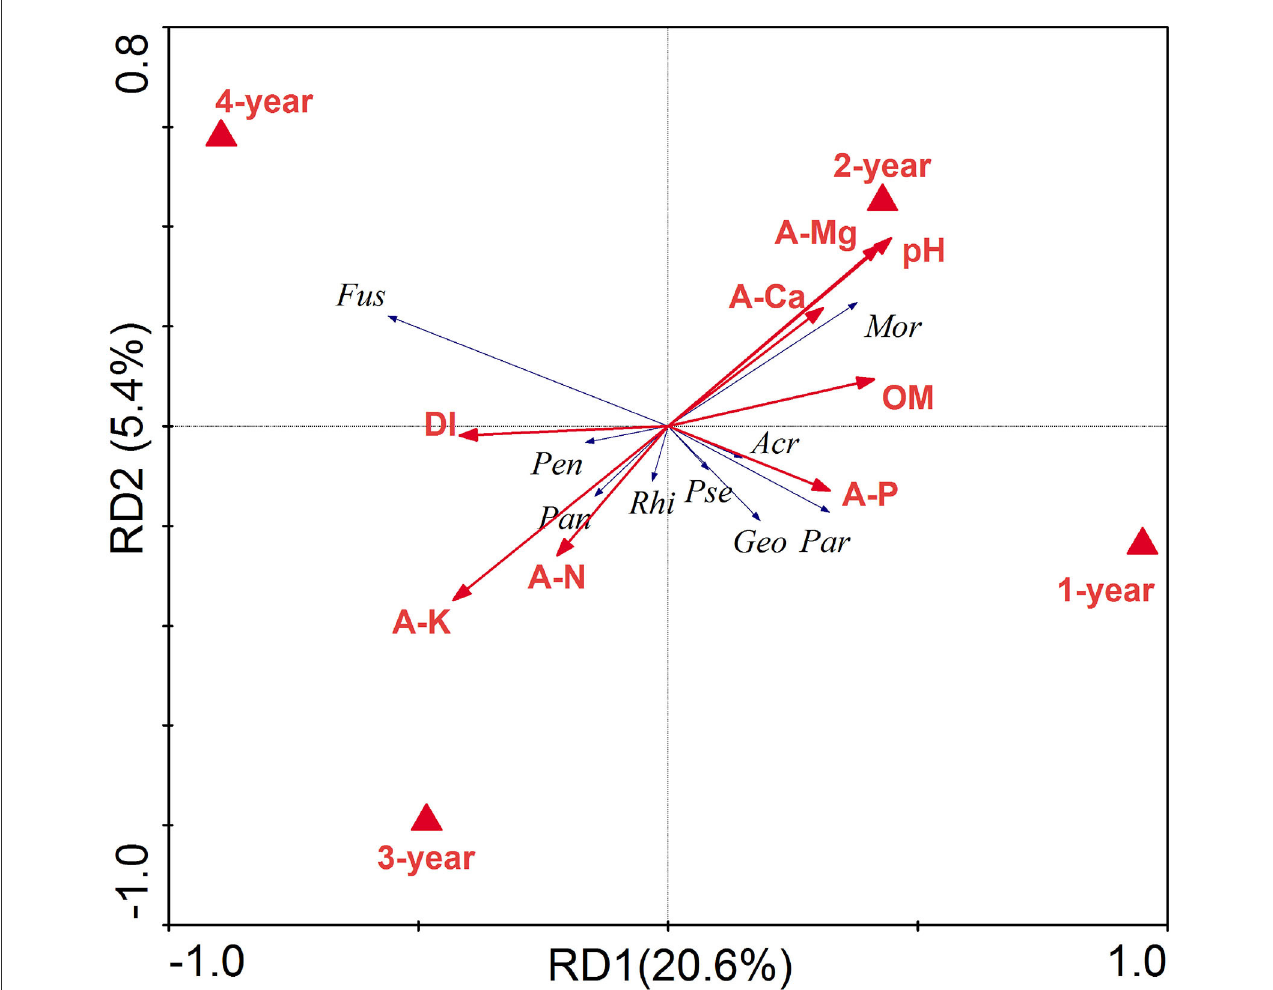
FIGURE6 Redundancy analysis (RDA) between soil chemical properties, Disease index (DI), and the relative abundance higher than 1% of microbial genera related with DI. The environmental parameters are represented by red lines, different treatments are solid triangles, and microbial genera are blue lines. Fus , Fusarium ; Rhi , Rhizomicrobium ; Pan , Pandoraea ; Mor , Mortierella; Pen , Penicillium ; Geo , Geomyces ; Acr , Acremonium ; Pse , Pseudeurotium ; Rhi , Rhizopus ; Par : Paraphaeosphaeria